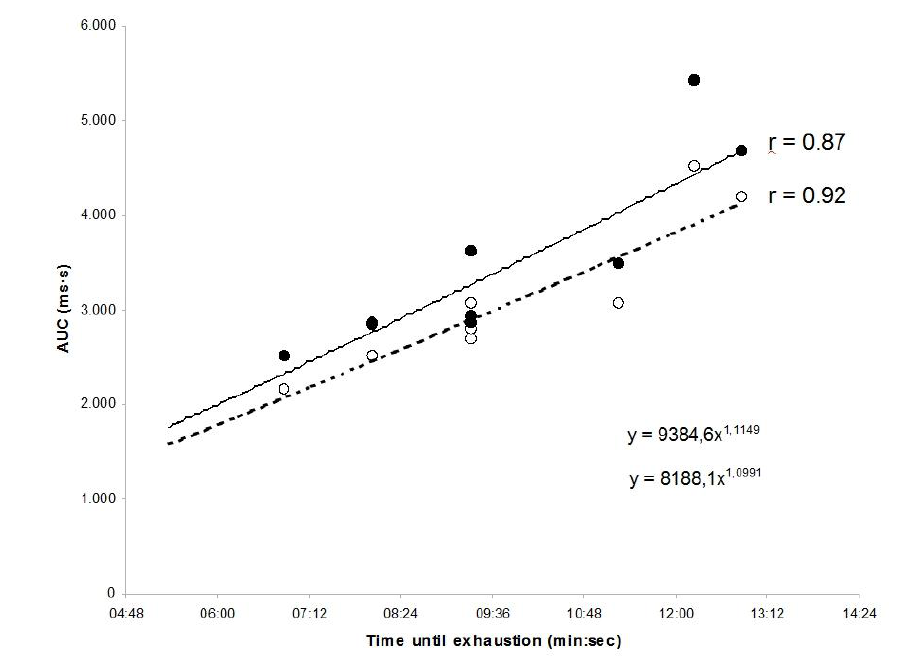
Figure 1. Exponential regression (n = 9) of basal SD1 (dotted line; white circles) and RMSSD (thick line; black circles) with exhaustion time in Yo-Yo intermittent recovery test level 1; r = Pearson product correlation